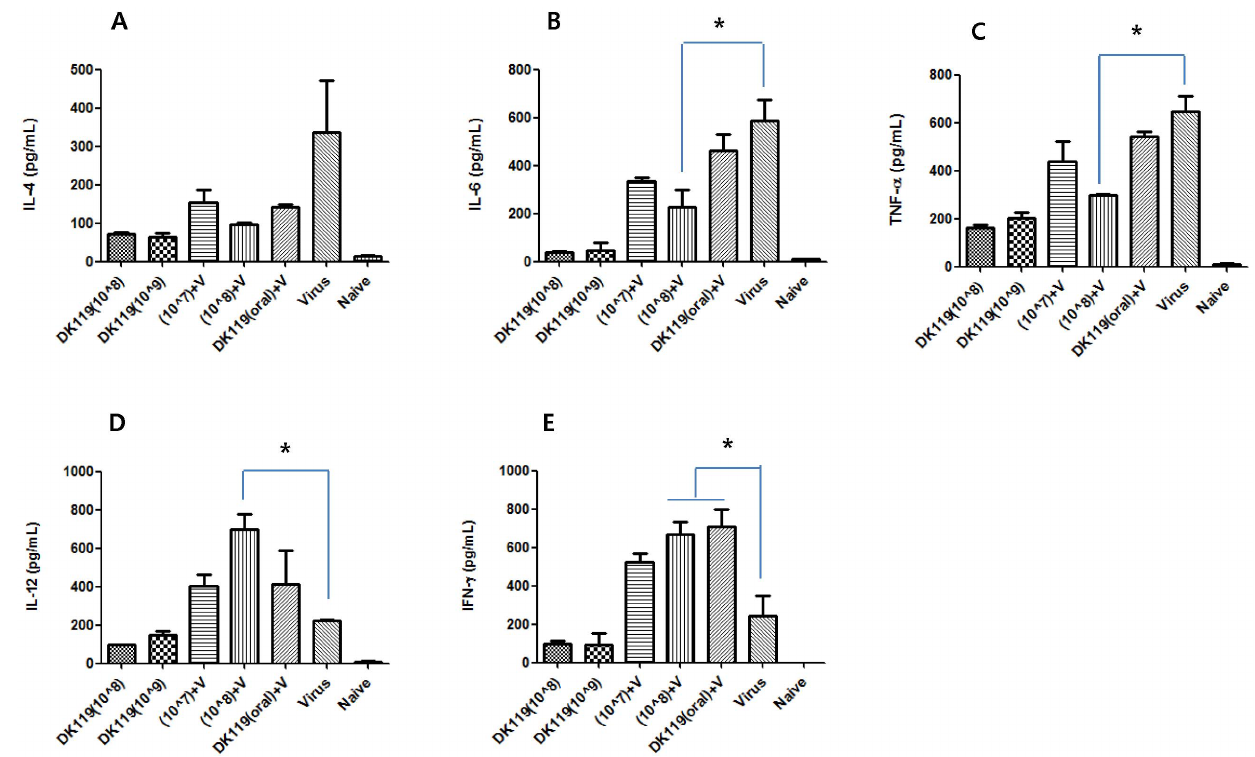
Figure 8. Effects of DK119 pretreatment on cytokine production upon influenza virus infection. Levels of cytokines in bronchoalveolar lavage fluids (BALF) collected from mice (n=3) at day 4 post infection with A/PR8 virus are presented in pg/ml as determined using cytokine ELISA. (A) IL-4, (B) IL-6, (C) TNF- a , (D) IL-12, (E) IFN- c . DK119 (10ˆ8): Intranasal DK119 10ˆ8 control in the absence of A/PR8 virus infection. DK119 (10ˆ9): Intranasal DK119 10ˆ9 control in the absence of A/PR8 virus infection. (10ˆ7) + V: DK119 (10ˆ7) intranasal pretreatment and then A/PR8 virus infection in the presence of DK119 (10ˆ9). (10ˆ8) + V: DK119 (10ˆ8) intranasal pretreatment and then A/PR8 virus infection in the presence of DK119 (10ˆ9). Virus: Naı¨ve mice infected with A/PR8 virus (2.5 LD 50 ). * indicates statistical significance compared to the control virus group (p , 0.05). Bars indicate standard errors.